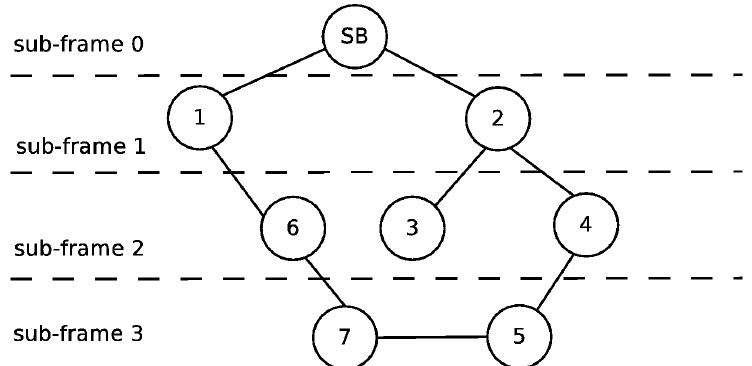
Figure 12. Topology of the network in Case 2.